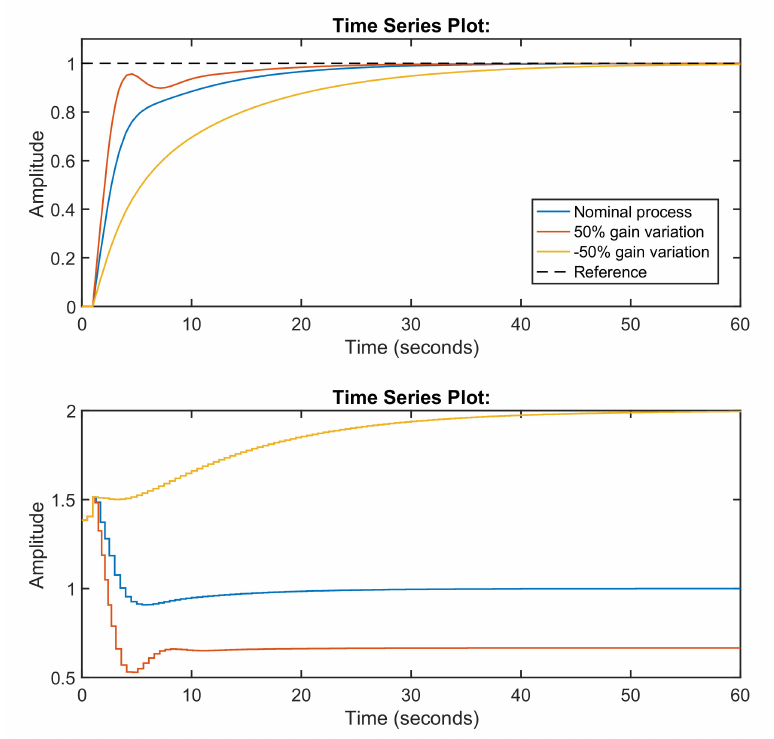
Figure 9. Robustness validation of the event-based PI controller (output signal in the upper plot, input signal in the lower